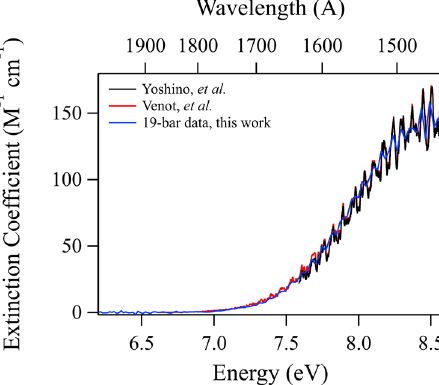
Fig. 3 Comparison of long-wavelength 19 bar supercritical CO 2 spectrum (308 K) to other results in the literature. Results are compared to those of Yoshino et al. 5,8 (295 K, blue) and Venot et al. 6,7 (300 K,